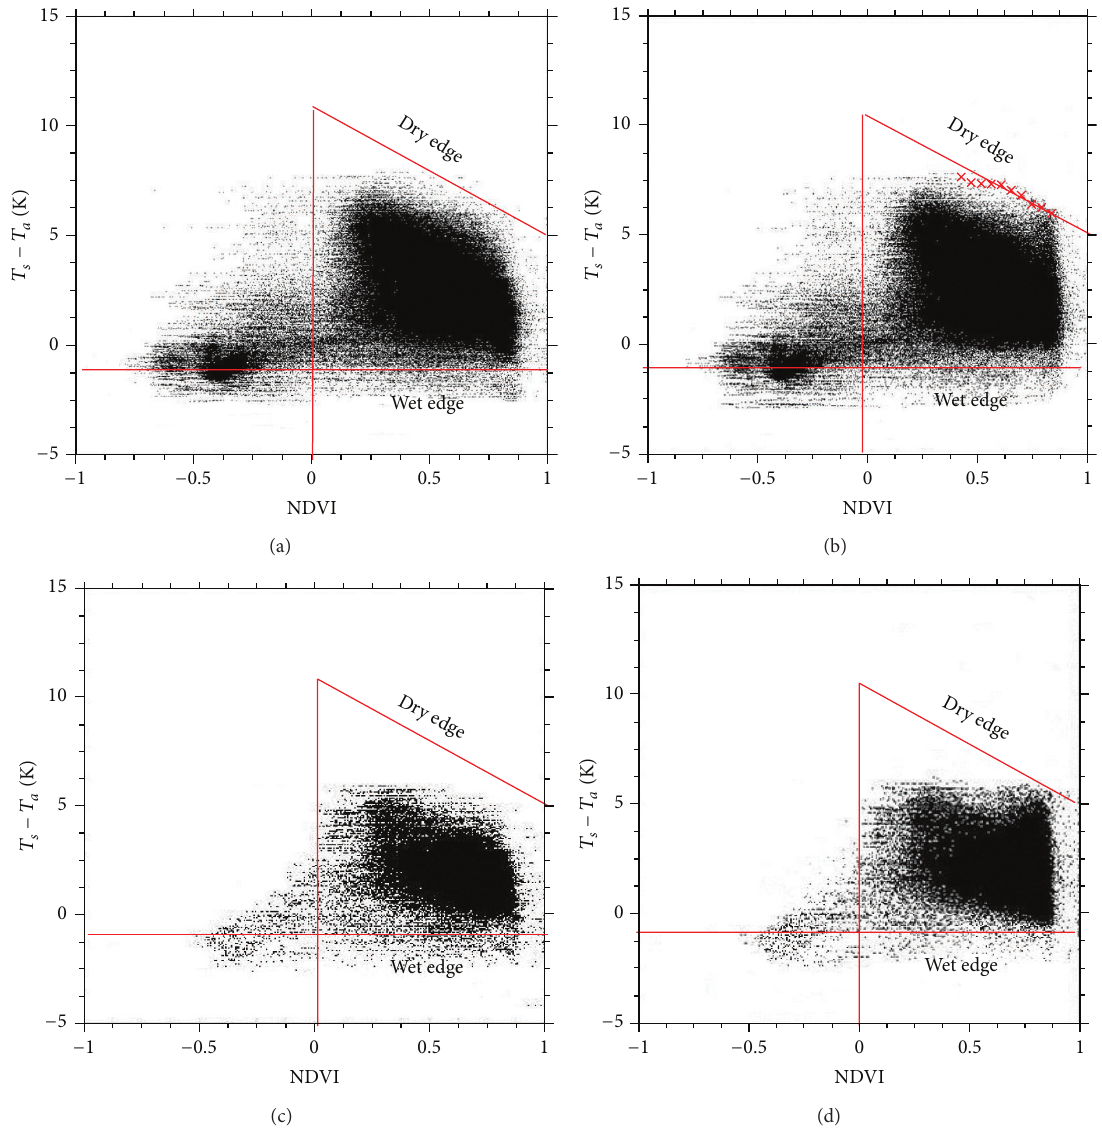
Figure 6: The surface-air temperature differences in the Normalized Difference Vegetation Index (𝑇 𝑠 −𝑇 𝑎 ) -NDVI scatter plots for a clear-sky day (Sept. 26, 2006) from MODIS data over the Taihu Basin. (a) Before the topographic correction, (b) after the topographic correction, (c) before the topographic correction over the selected area, and (d) after the topographic correction over the selected area. The dry (upper red line) and wet (lower red line) edges represent the maximum ET and minimum ET, respectively. The cross points of red lines, estimated by an automatically iterative method [25], were used to determine dry